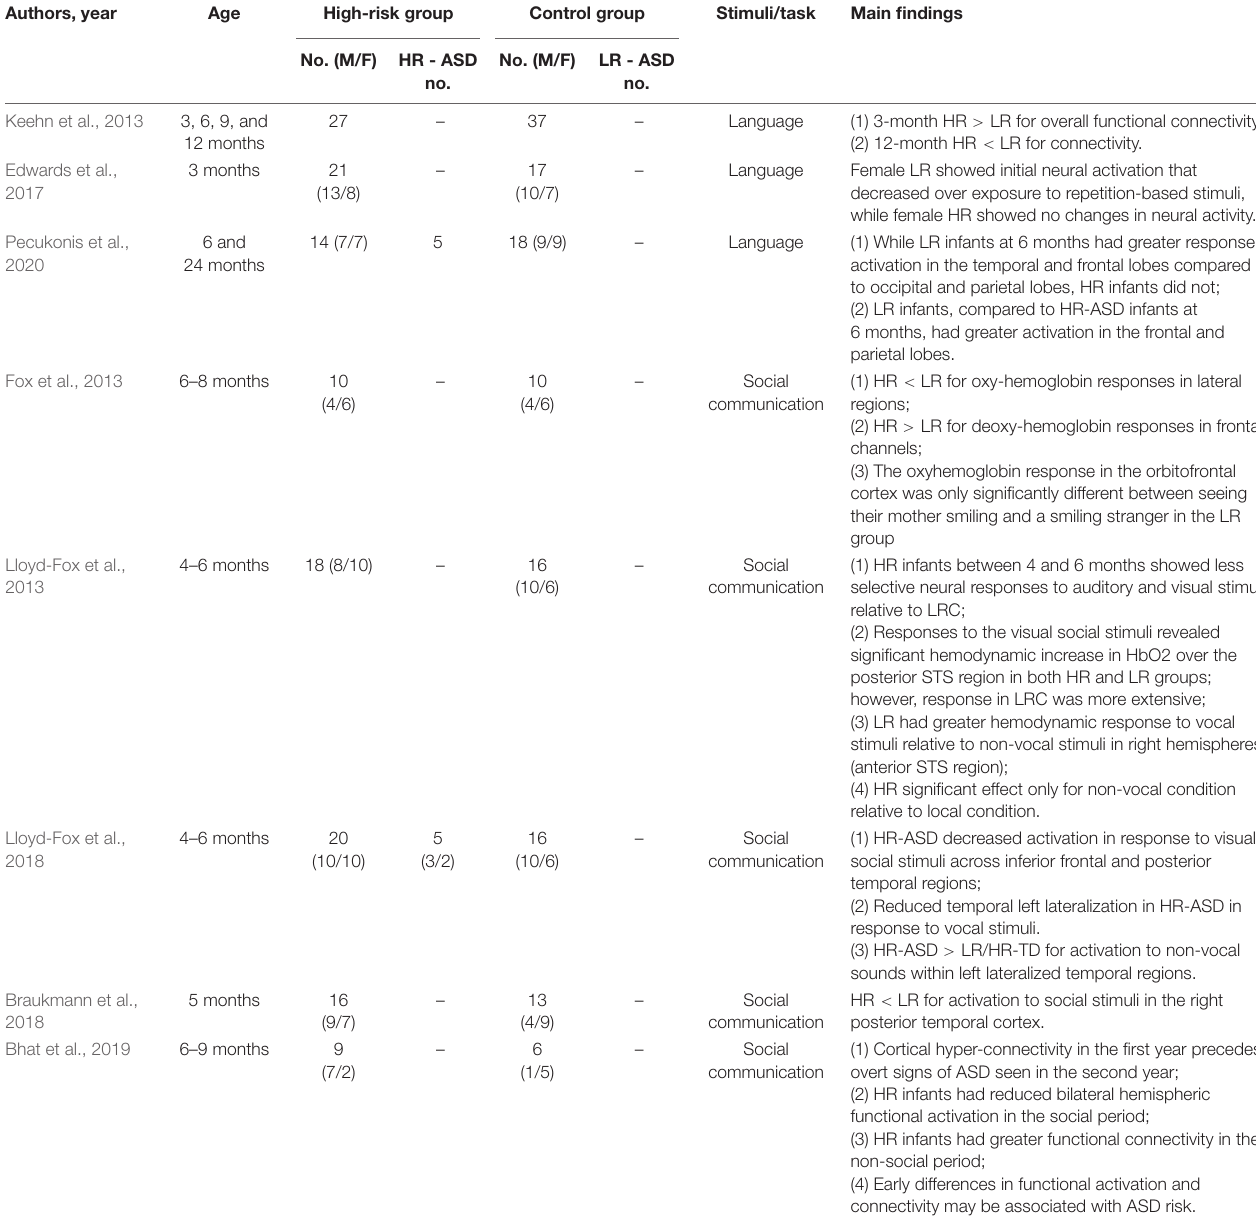
TABLE 3 | Functional near-infrared spectroscopy (fNIRS) studies on early screening of autism spectrum